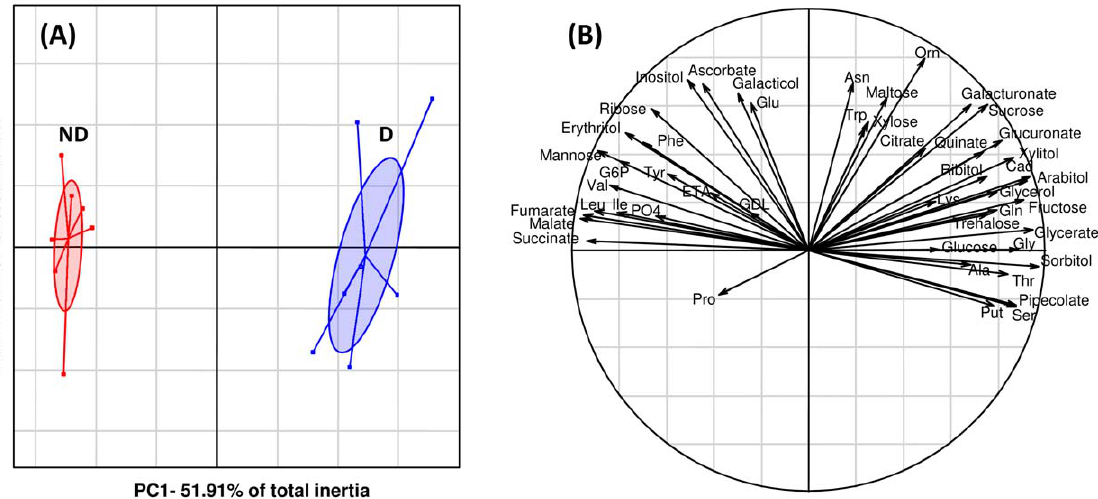
Figure 2. Multivariate analysis (PCA) on metabolomic data. Panel A illustrates that plotting the first two principal components (PCs) results in a clear-cut separation of diapausing (D) and nondiapausing (ND) metabotypes along PC1. Lines link individuals to their respective centroids ( n =7). Projection of the 48 variables on the correlation circle is shown in panel B.